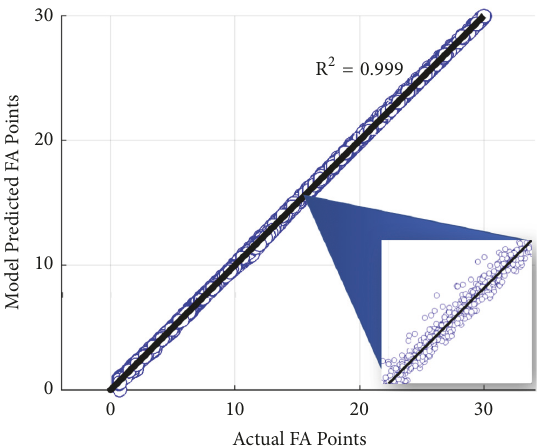
Figure 4: Plot of calculated functional anteversion based on the geometric model versus functional anteversion generated by the regression model equation (blue dots). Using 10,560 points, the equation was generatedand fits the data (black line) with R 2 = 0.999.